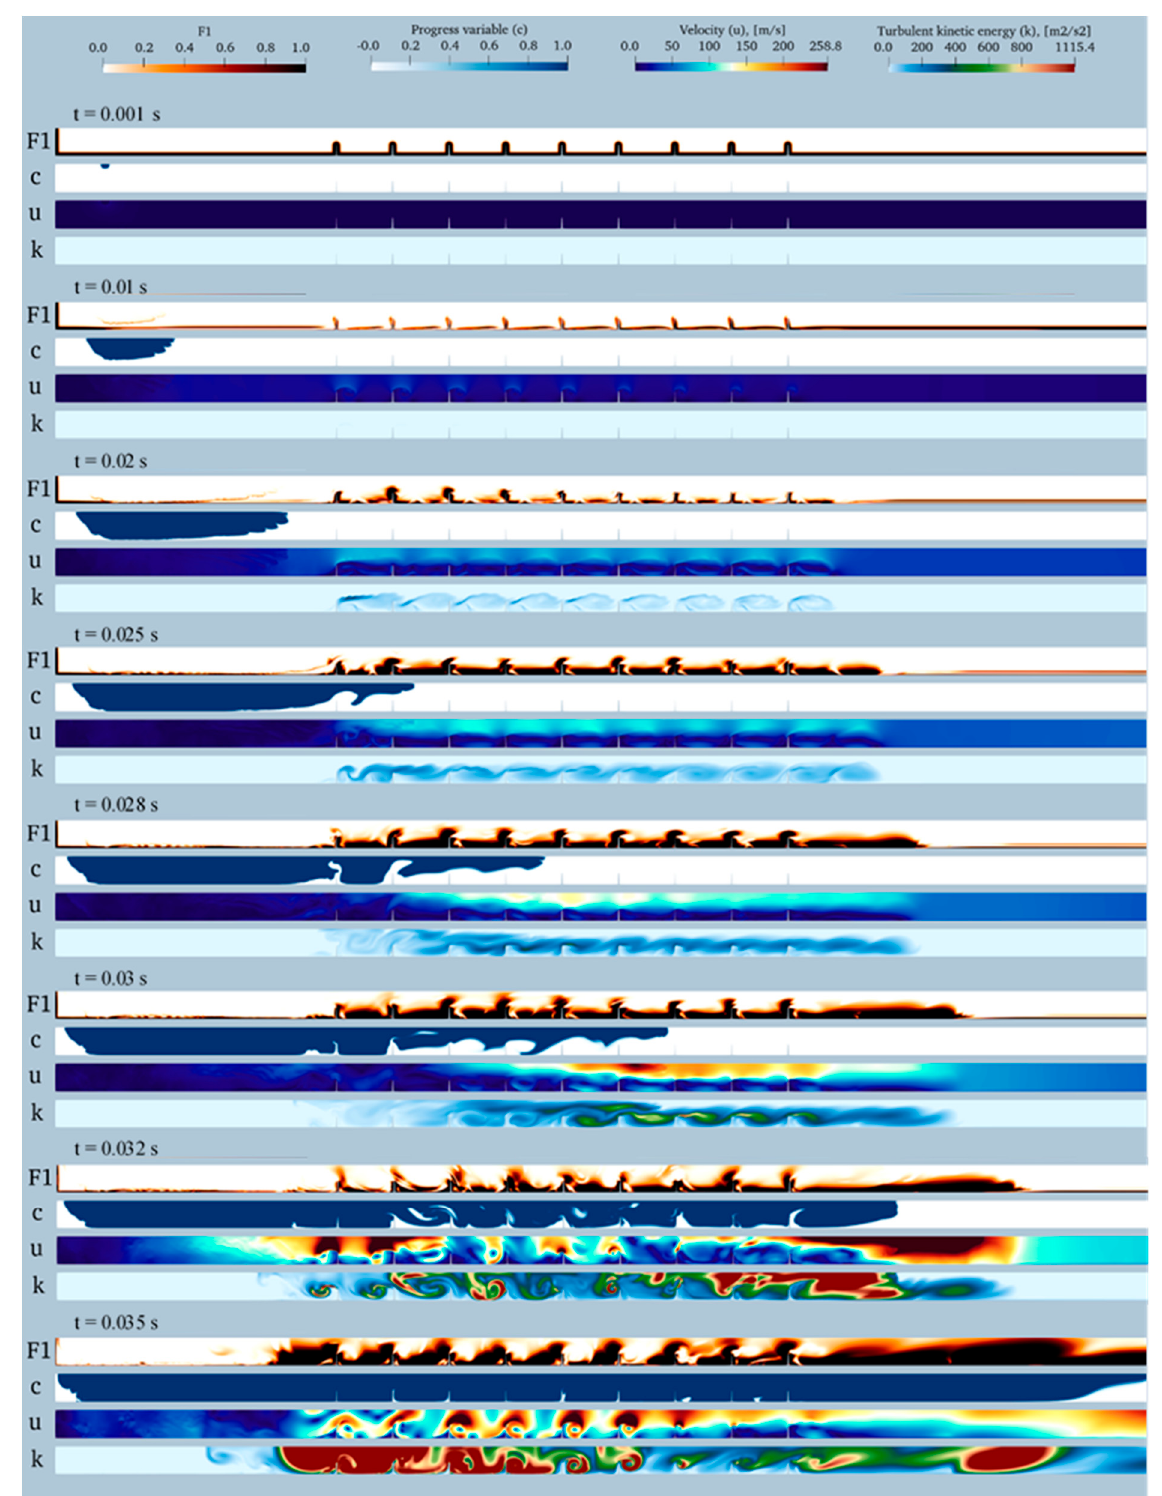
Figure 6. F1 function, progress variable, velocity, and turbulent kinetic energy fields (Bradley correlation, 0% diluents).